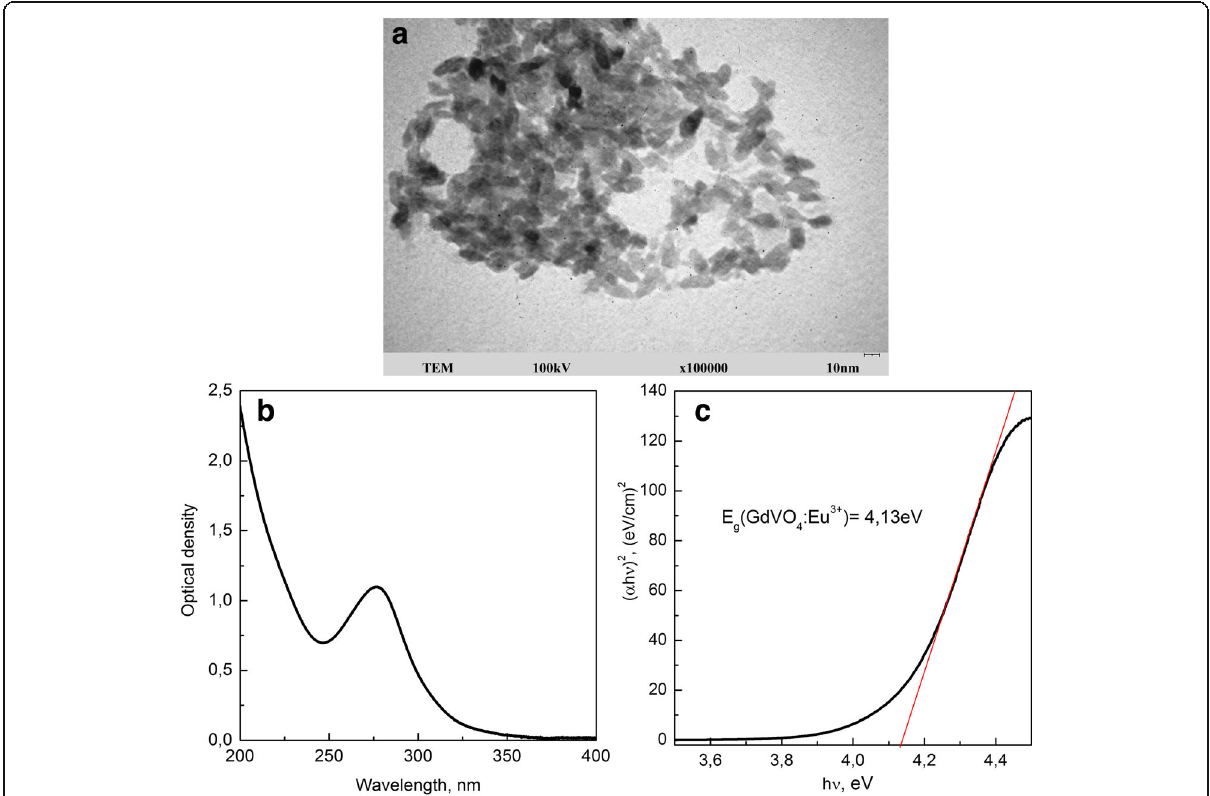
Fig. 1 TEM image ( a ), absorption spectrum ( b ), and energy dependence of ( α hv ) 2 ( c ) of GdVO 4 :Eu 3+